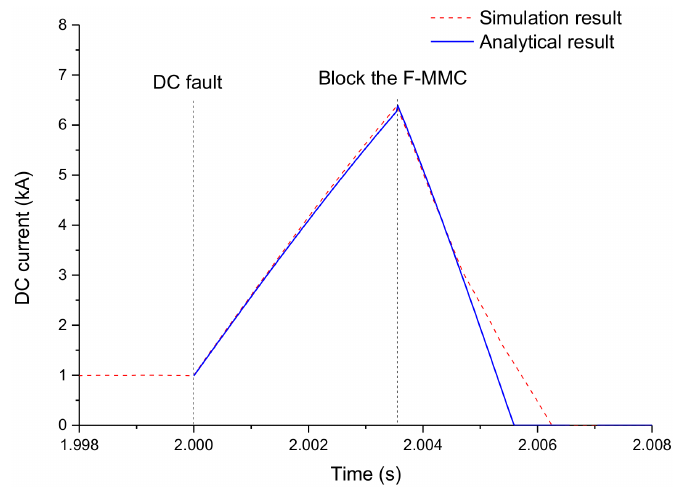
Figure 14. DC current of MMC with solution 2 when AC system is